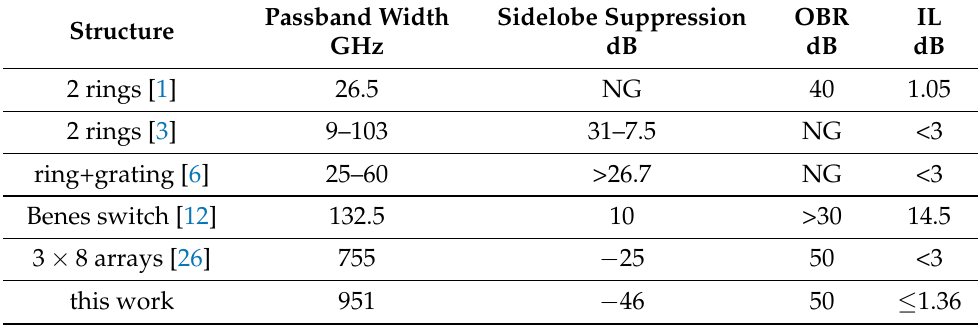
Table 1. Comparison of the multiple rings